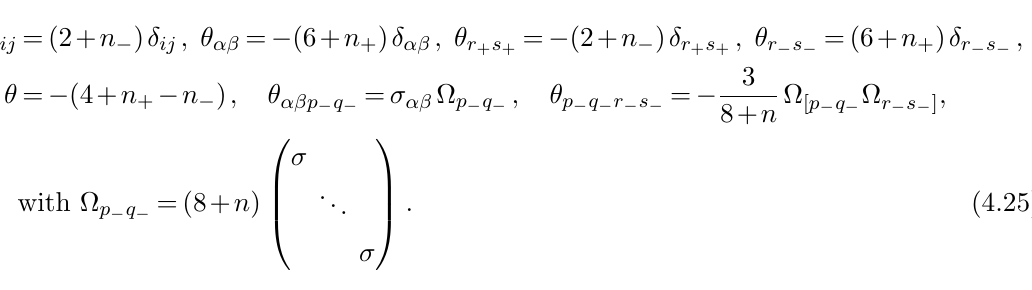
Table 14. Mass spectra for the SU(4 and n = 2. The gauge group is SO(6 ; n + ) (cid:0) if n (cid:0) = 2 m , whereas they imply that all f i vanish for n (cid:0) = 2 m +1. Thus, for (cid:20) are solutions with non-vanishing (cid:18) MNPQ only if n (cid:0) = 2 m is even, and they are given